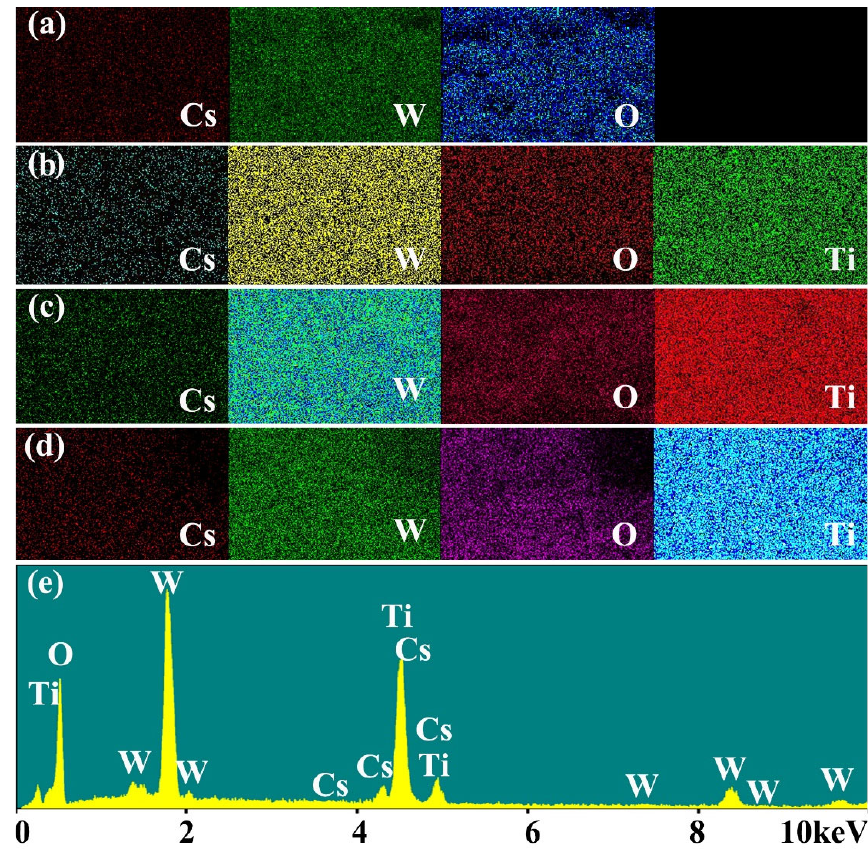
Figure 3. Element mapping of ( a ) CWO, ( b ) CWO@0.2TiO 2 , ( c ) CWO@0.4TiO 2 , ( d ) CWO@0.6TiO 2 ; ( e ) Element spectrum of CWO@0.2TiO 2 .